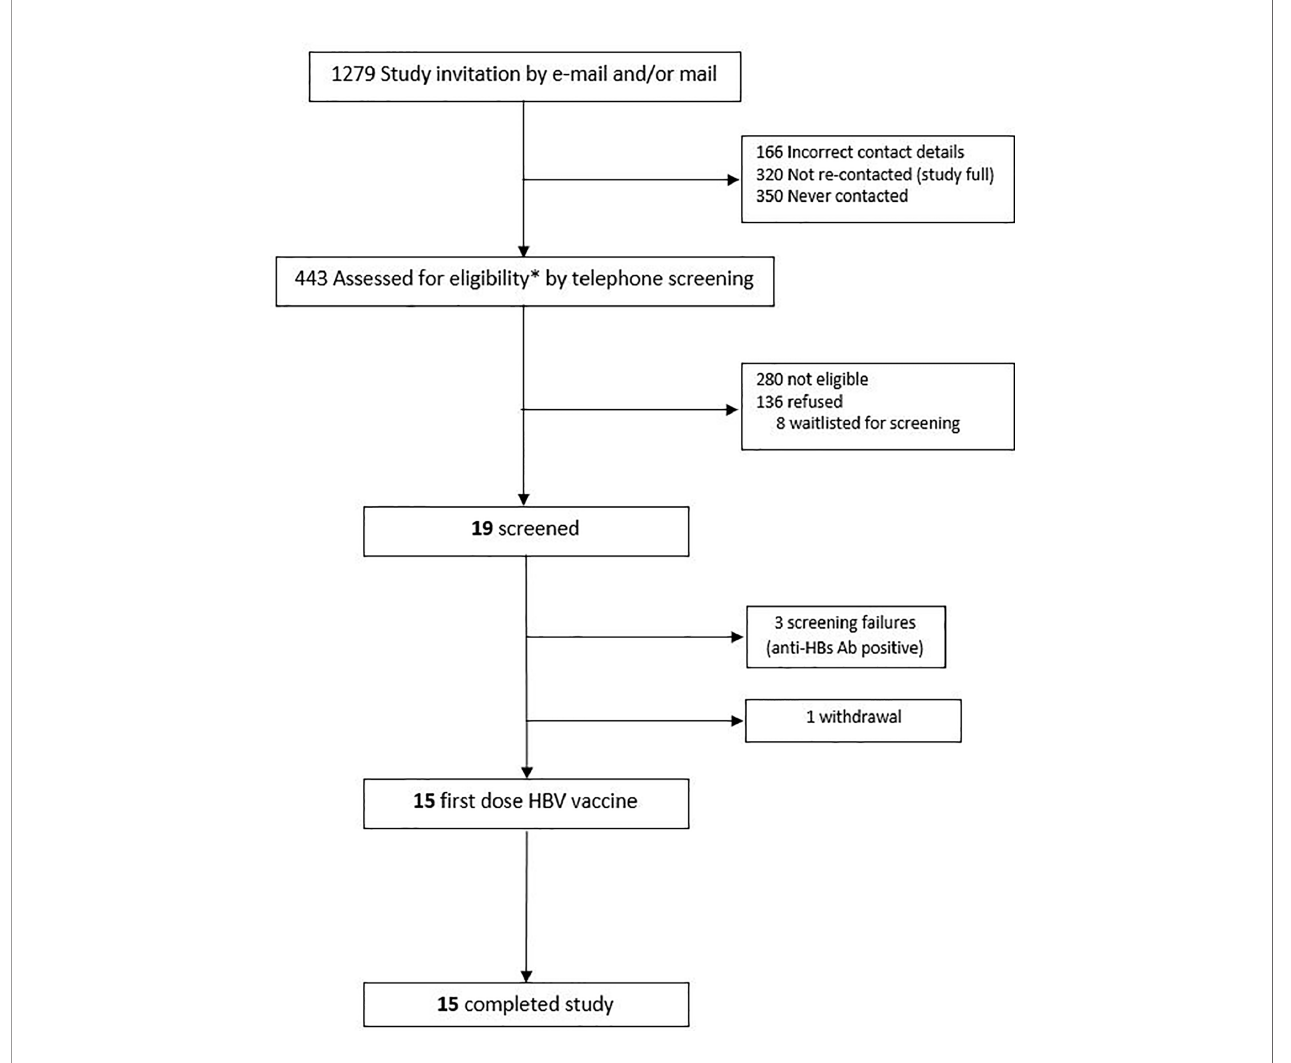
FIGURE 1 | Study participants recruitment strategy.